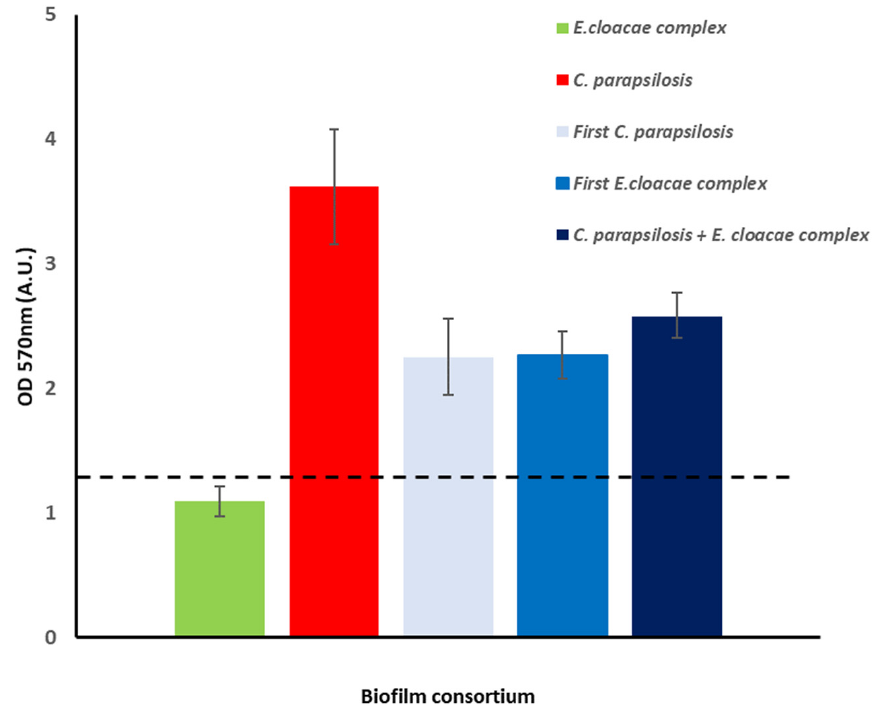
Figure 3. Biofilm assay. Single and dual biofilms of E. cloacae complex ( E. bugandensis ) and C. parapsilosis were monitored using crystal violet assay. Dual biofilms were either initiated by C. parapsilosis (First C. parapsilosis ) or E. cloacae complex (First E. cloacae complex) or both microorganisms ( C. parapsilosis + E. cloacae complex). The dashed line (—) highlights the OD 570nm value corresponding to the cut-off value for strong biofilm producers (SBP) according to Stepanovi´c criteria [32]. A.U.: arbitrary units.